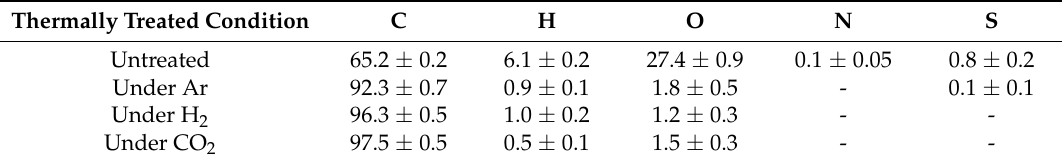
Table 3. Summary of weight percentages (wt %) of C, H, O, N, and S in untreated kraft lignin and solid products of kraft lignin thermally decomposed under argon, hydrogen, and carbon dioxide at 1000 ◦ C for 1